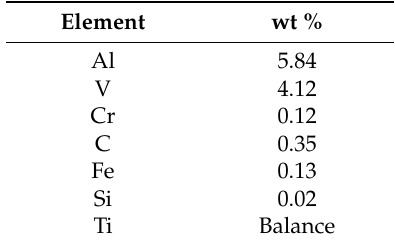
Table 1. Chemical composition of